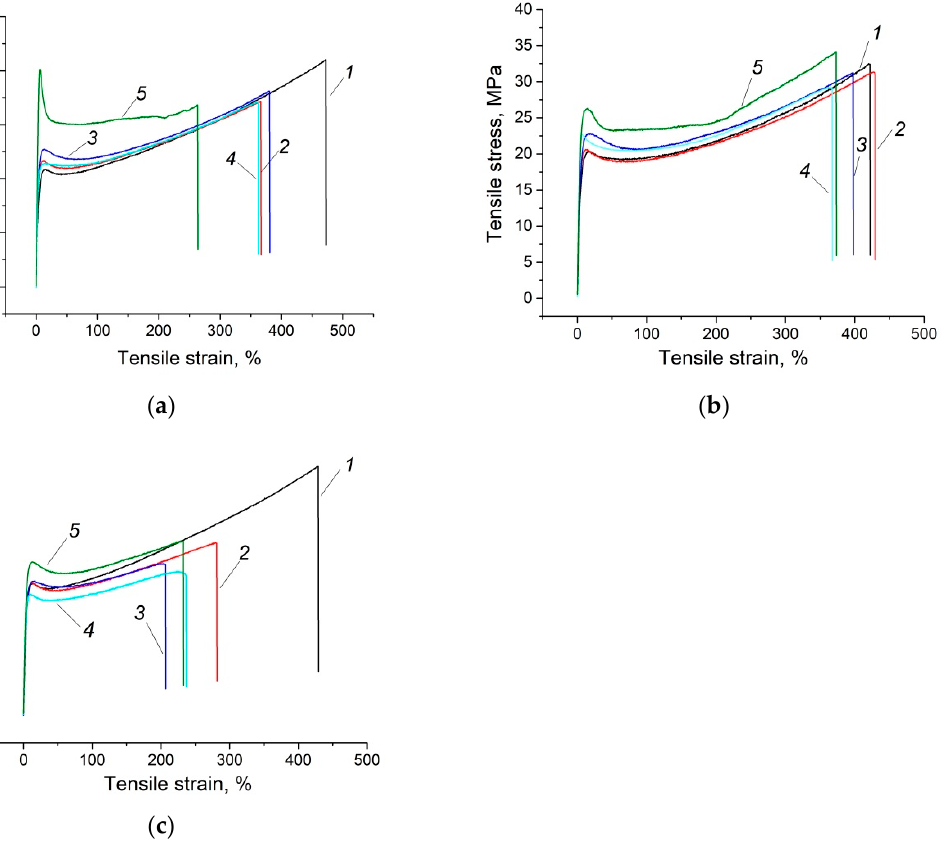
Figure 2. Engineering Stress-strain Curves for GUR 2122 ( a ); GUR 4120 ( b ); GUR 4022-6 ( c ): 1—neat GUR 2122; 2—“GUR 2122 + 10% MGF annealed” composite; 3—“GUR 2122 + 10% MGF annealed and treated with “KH-550”” composite; 4—“GUR 2122 + 10% LGF annealed” composite; 5—“GUR 2122 + 10% LGF annealed and treated with “KH-550”” composite.